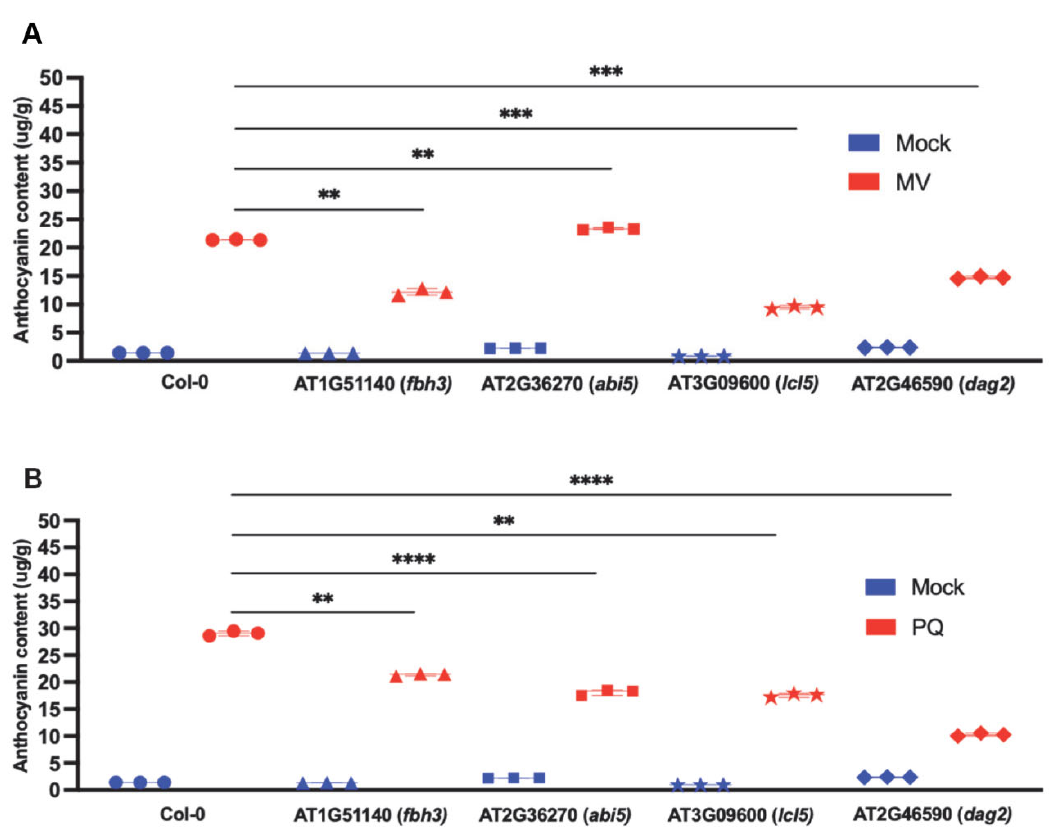
Figure 7. Anthocyanin content in leaves of 7 days old Arabidopsis plant in MS media and different stress conditions. ( A ) 2uM Methyl viologen (MV) treatment, n = 12 (three biological replicates) ( B ) 2uM paraquat (PQ) treatment, n = 12 (three biological replicates). Asterisks represented statistical signi fi cance (** p < 0.005, *** p < 0.0005, and **** p < 0.00005, Student’s t-test. The symbol ⬤ indicates Col-0, ▲ represents fb h3 mutant, ◼ signi fi es abi5 mutant, ★ identi fi es lcl5 mutant and ⯁ indicates dag2 mutant.